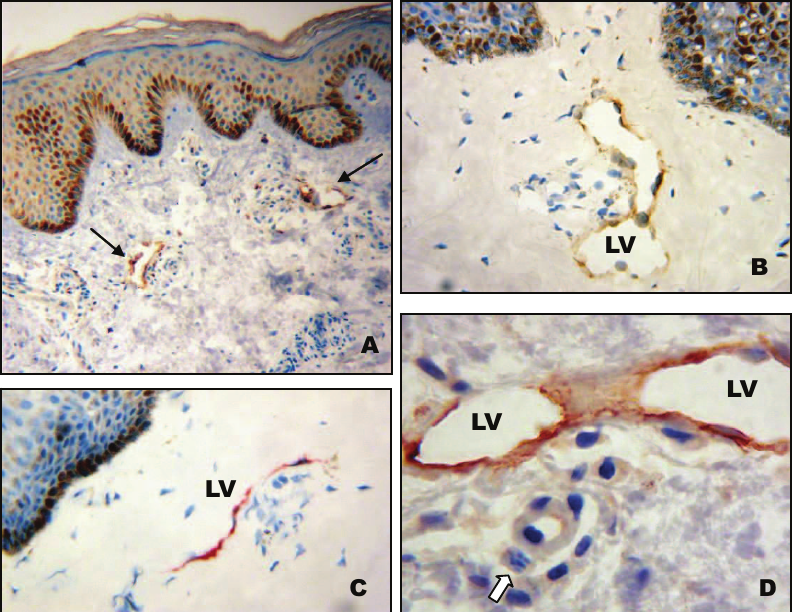
Figure 4. Localisation of microfilariae in the dermis of onchocercian patients. (A) Lyve-1 staining showing two dilated lymphatic vessels (black arrow)on a paraffin section (B) Lyve-1 staining revealing one dilated lymphatic vessel with mononuclear cells on a cryosection (C) Podoplanin staining showing a collapsed lymphatic vessel on a cryosection. (D) Microfilaria (white arrow) section in a perivascular space near to a lymphatic vessel. Number of analysed skin snips=8. Scales: A,B,C,D, bar=50 m m.